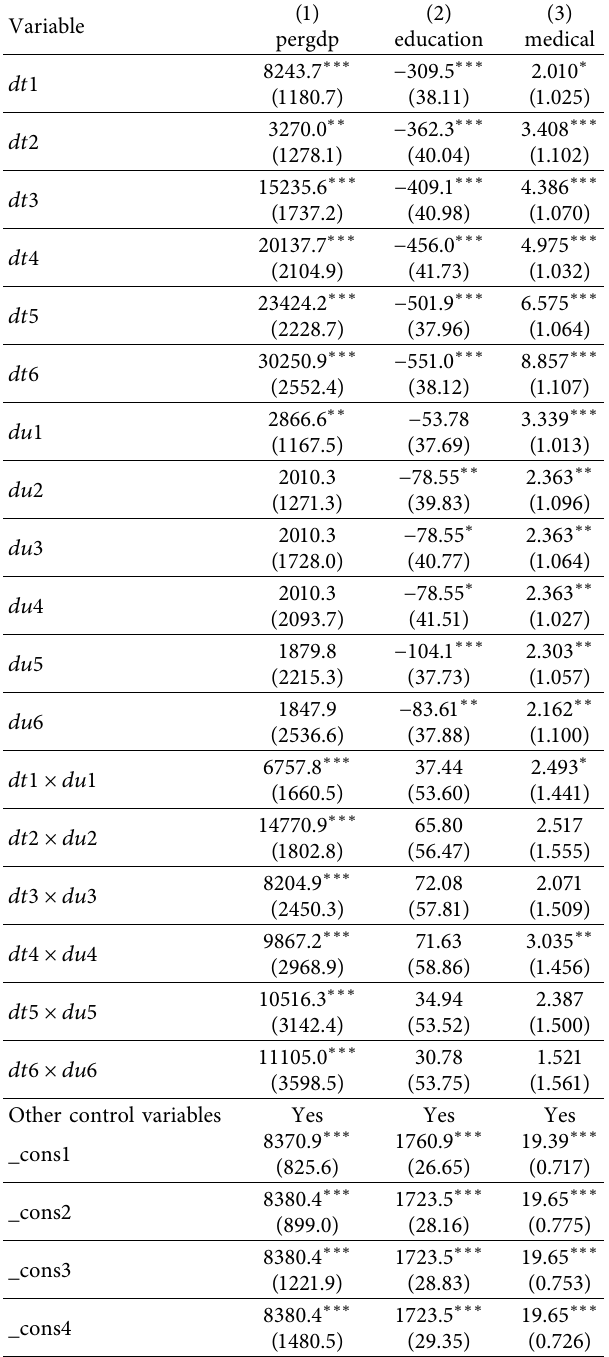
“+” in the table represents positive action and “ − ” represents negative efect. Table 5: PSM-DID dynamics test results of TCID on economic growth and public service